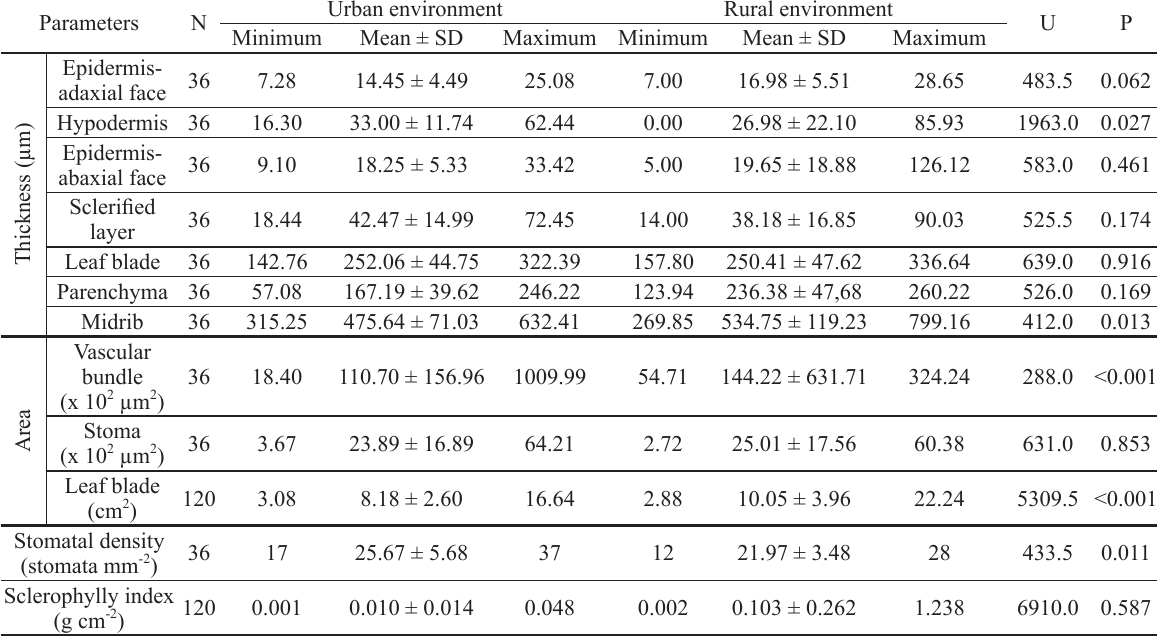
Values (mean, minimum and maximum) of morphometric parameters of Microgramma squamulosa fertile leaves in urban and rural environments (N=number of measured leaves per environment; SD=standard deviation; U=Mann Whitney test;